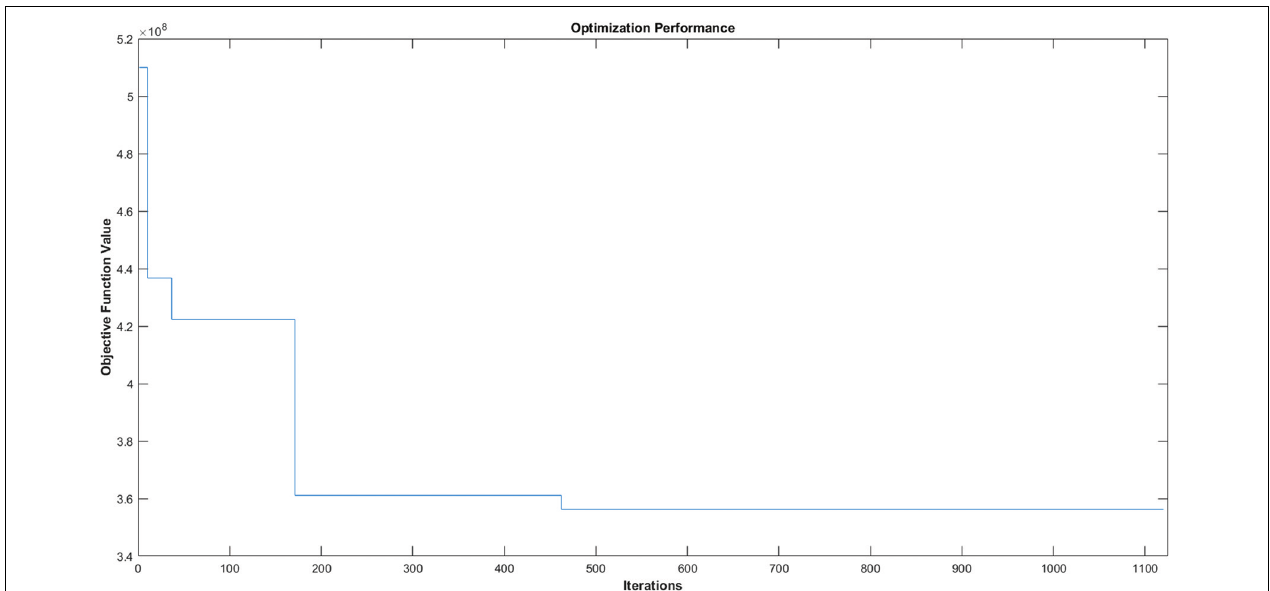
FIGURE 10 | Best objective function